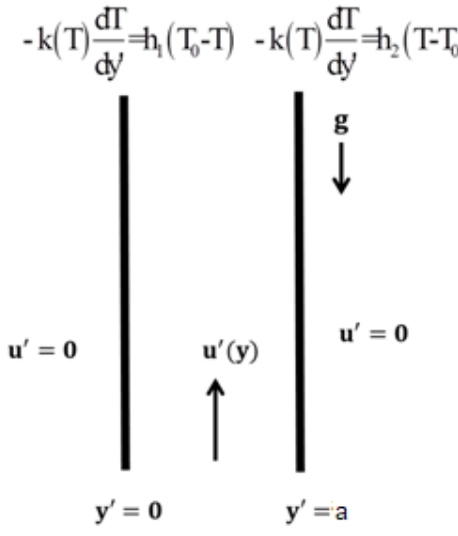
Figure -1. Flow geometry. Figure 1. Flow